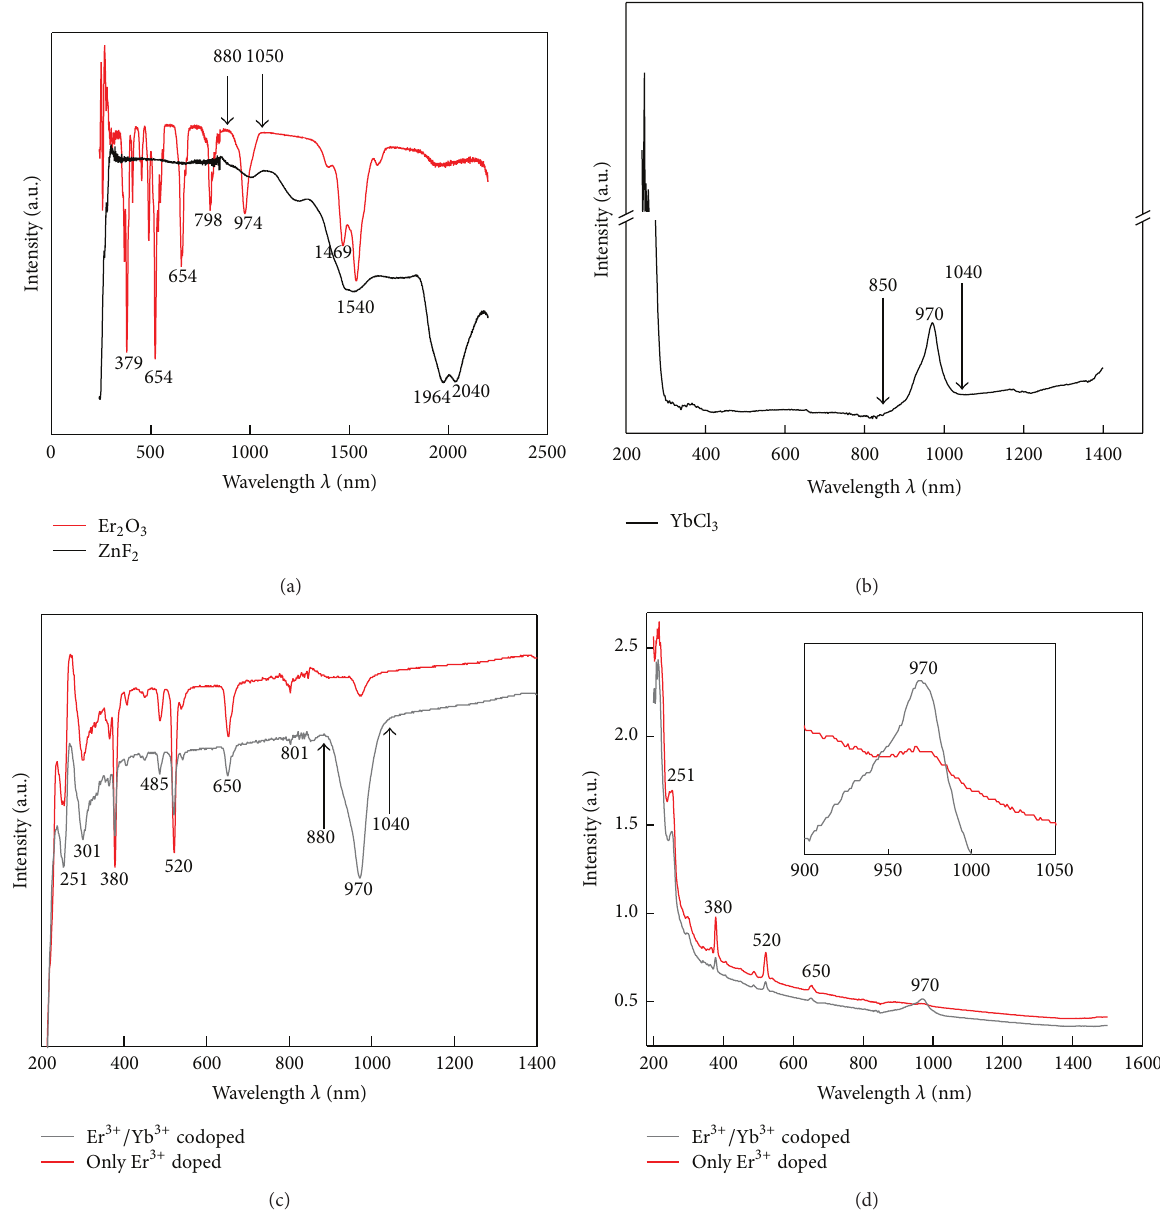
Figure 4: (a) Reflection spectra of Er 2 O 3 and ZnF 2 ; (b) absorption spectra of YbCl 3 ; (c) reflection and (d) absorption spectra of Er 3+ doped, Er 3+ /Yb 3+ codoped